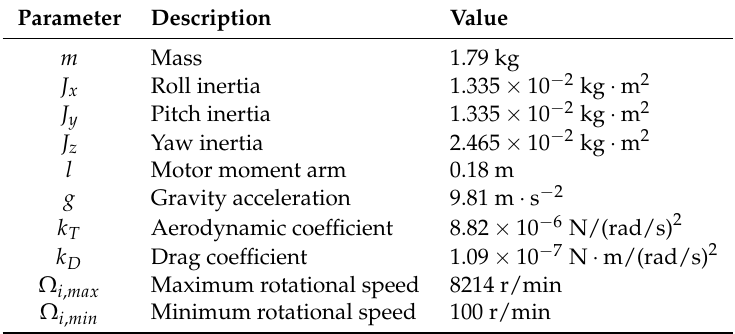
Table 1. Quadrotor parameters used in